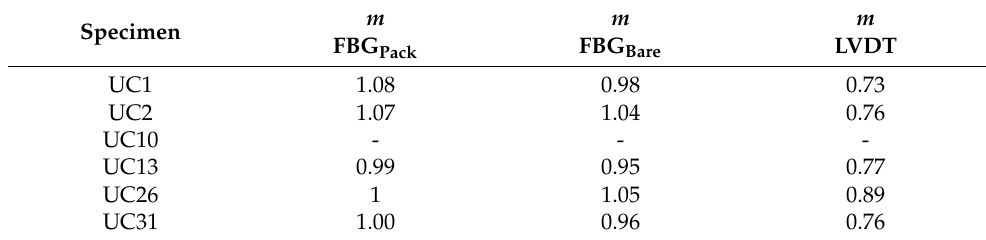
Table 3. Variation of m for sensors across the